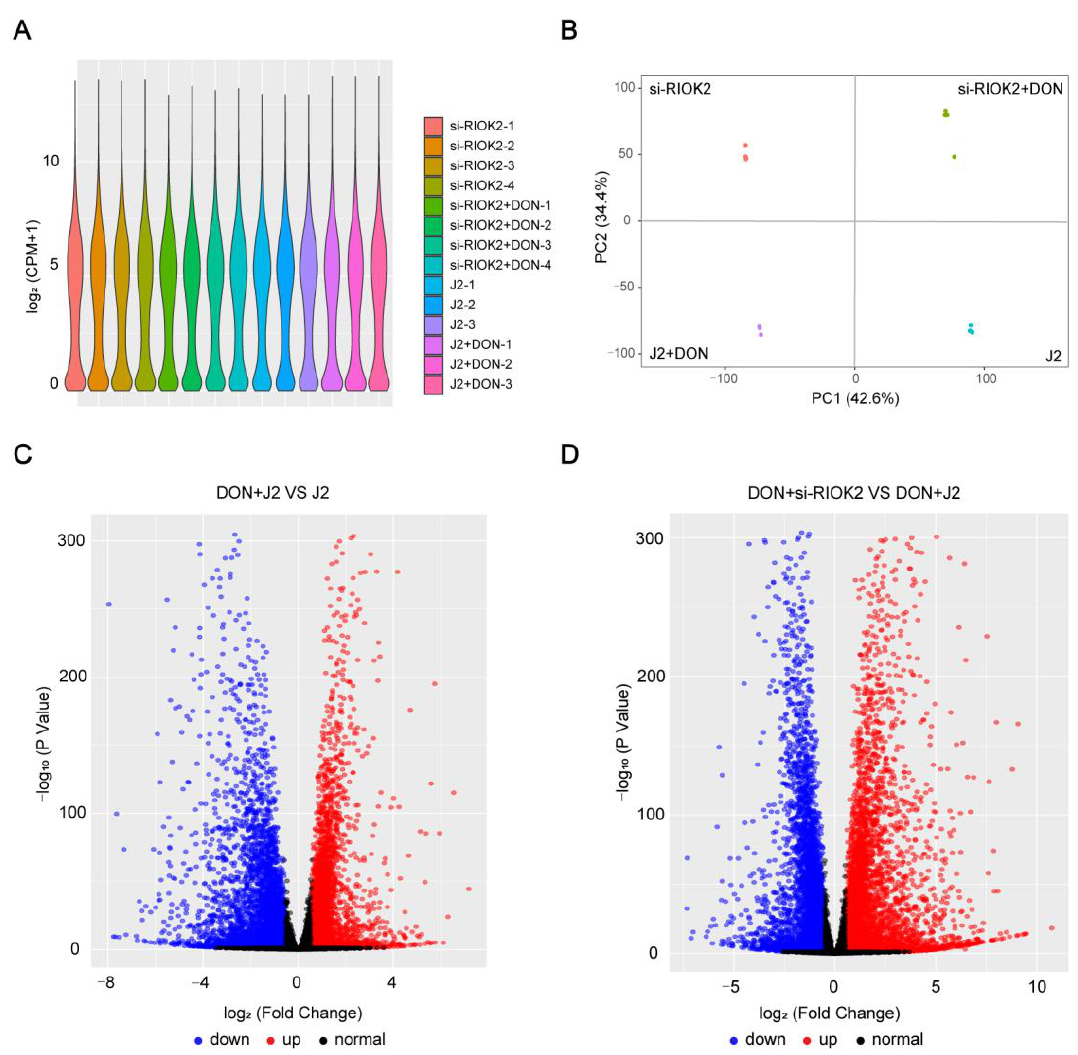
Figure 3. Data quality control of RNA-seq and preliminary analysis. ( A ) Violin box plot of CPM distribution among all the samples. ( B ) Principal component analysis of the four groups of samples. PC1 means 42.6 of the variance, and PC2 means 34.4% of the variance. ( C , D ) Volcano plots of the differentially expressed genes. The blue, red, and black nodes represent downregulated, upregulated, and normal genes, respectively.